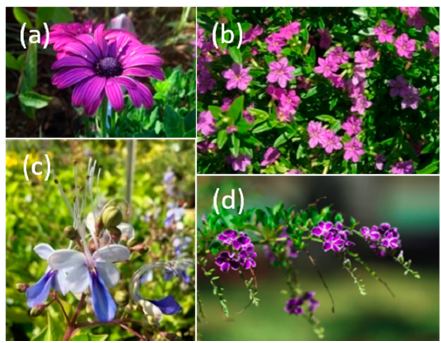
Figure 1. Speciesoftheexperimentalexoticplantcommunities: ( a ) Osteospermum sp., ( b ) Cupheahyssopifolia , ( c ) Clerodendrum ugandense , and ( d ) Duranta erecta